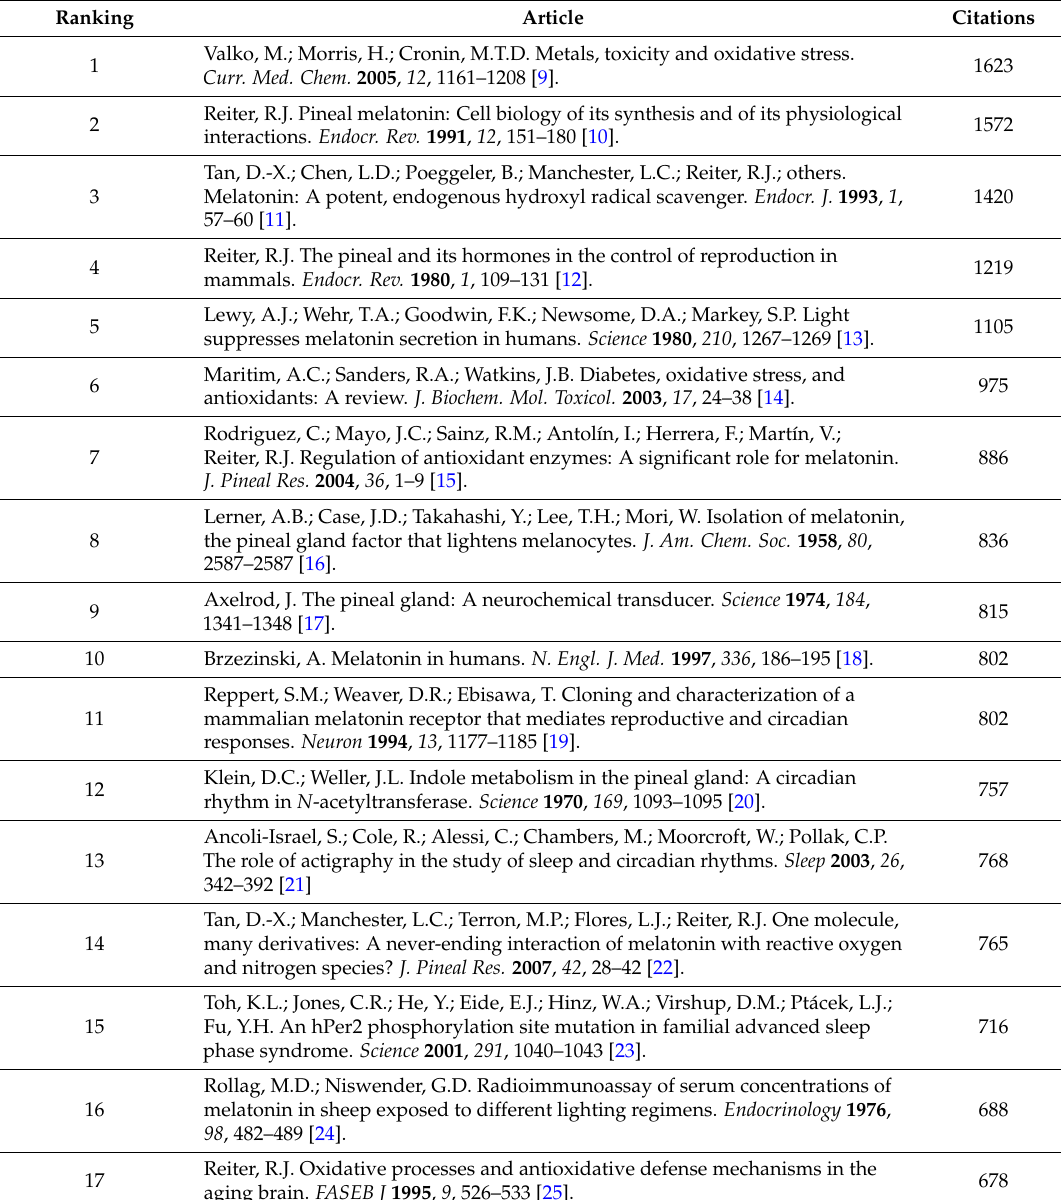
Table 1. Top-100 rank of the most cited articles in the field of melatonin